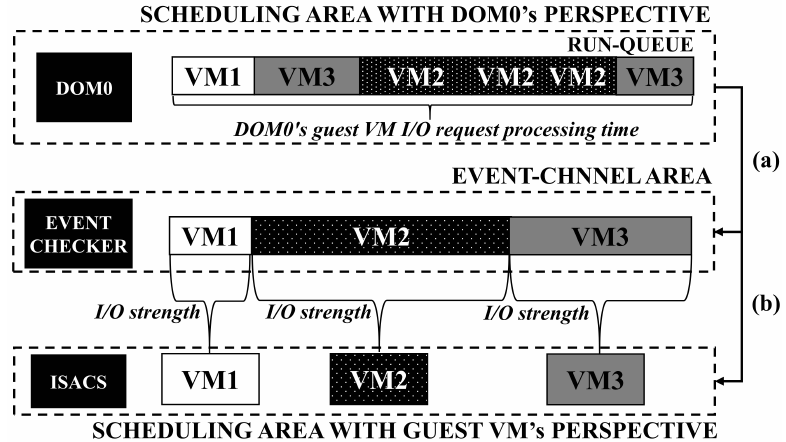
Figure 4. ISACS vCPU I/O strength measurement